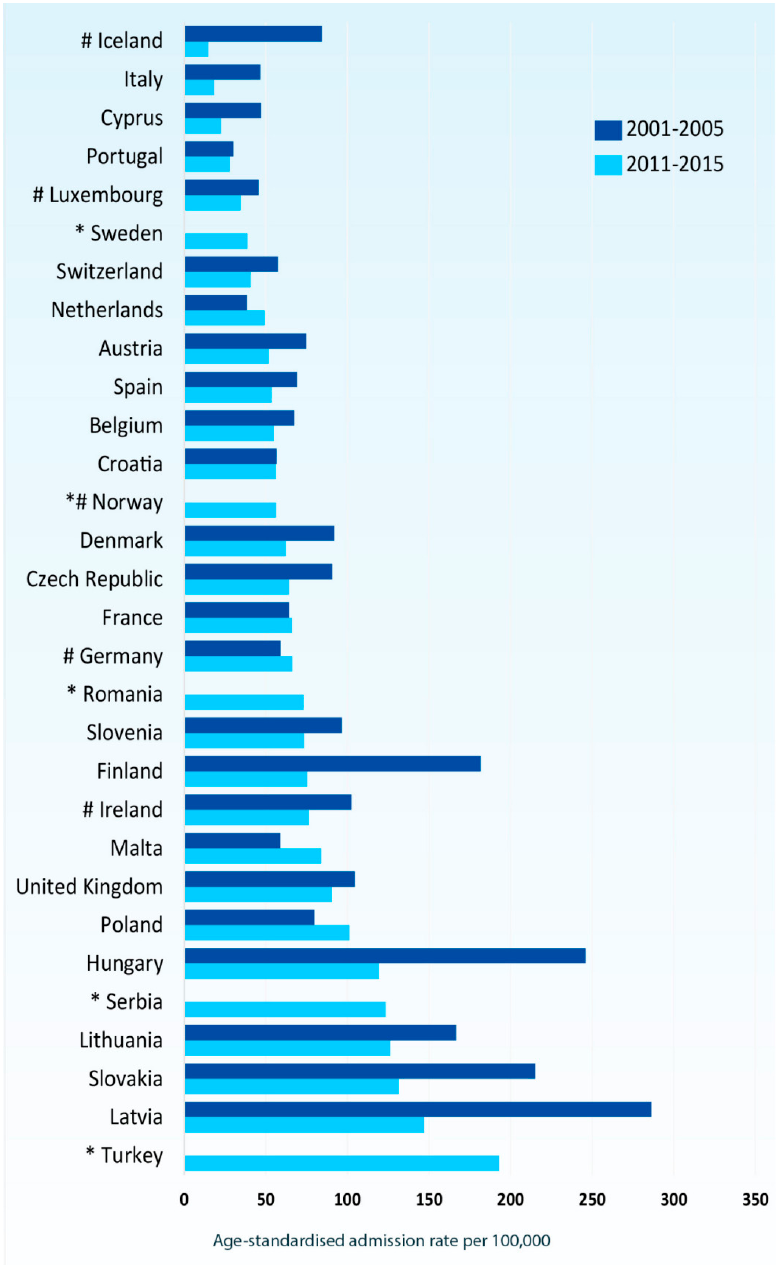
Figure 1. Age-standardized admission rates for asthma (all ages) in 30 European countries in two time periods: 2001–2005 and 2011–2015. Source: Eurostat updated from ec.europa.eu/Eurostat/web/health/health-care/data/database (version dated November 2017).